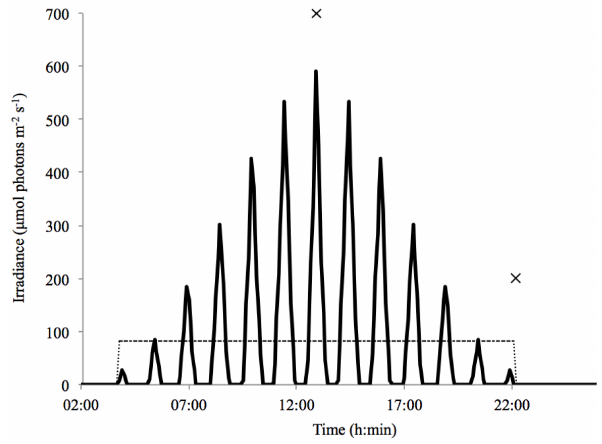
Figure 1. Light regimes plotted as a function of time over a 24h period. Indicated are the dynamic light cycle (solid line) and the constant light cycle (dashed line). Time points 1 and 2 are displayed at midday and in the evening at the start of the dark period ( ×